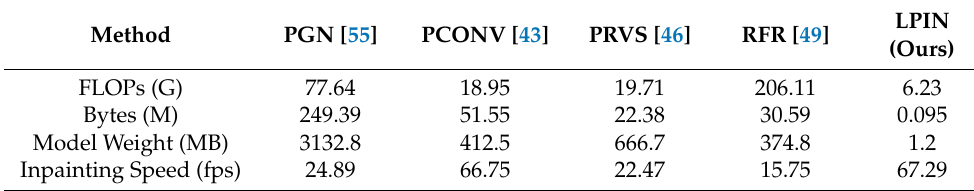
Table 2. Model Weight and Inpainting Speed of Different Models.